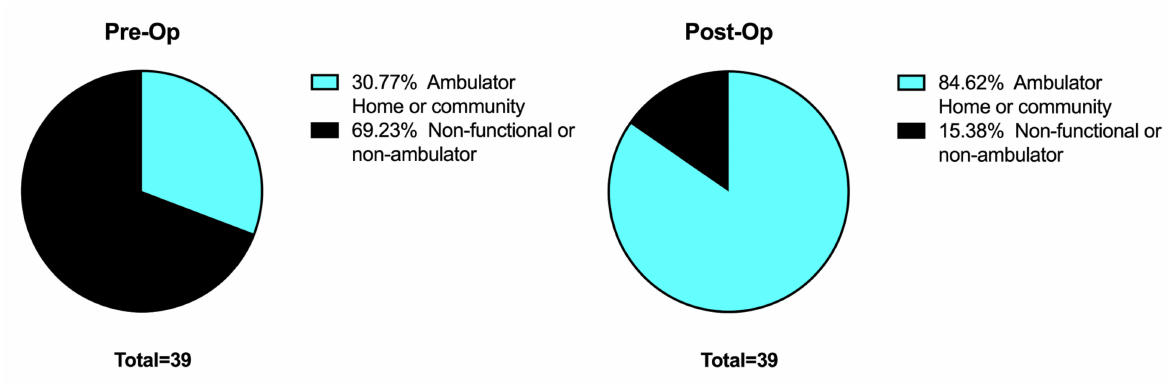
Figure 15. Ambulation pre and post